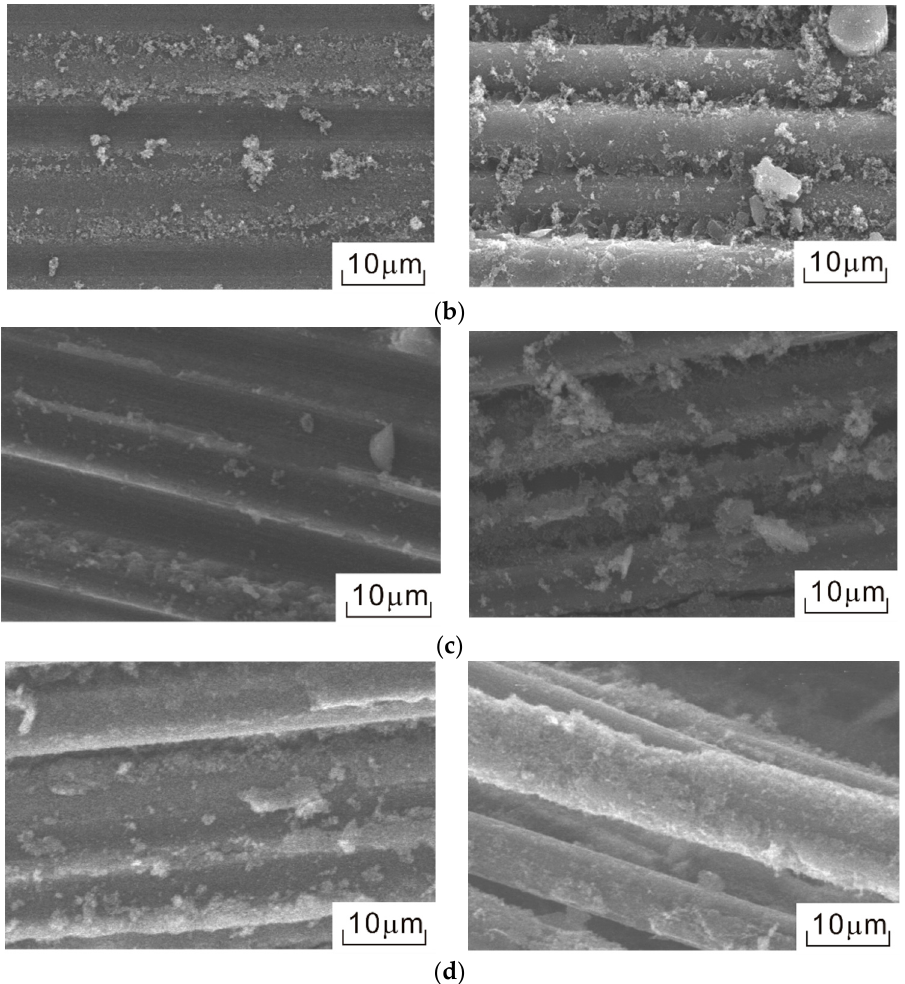
Figure 16. SEM images of the fracture surfaces of the flexural tests of ( a ) As ‐ received, ( b ) CNT10, ( c ) CNT30 and ( d ) CNT60.